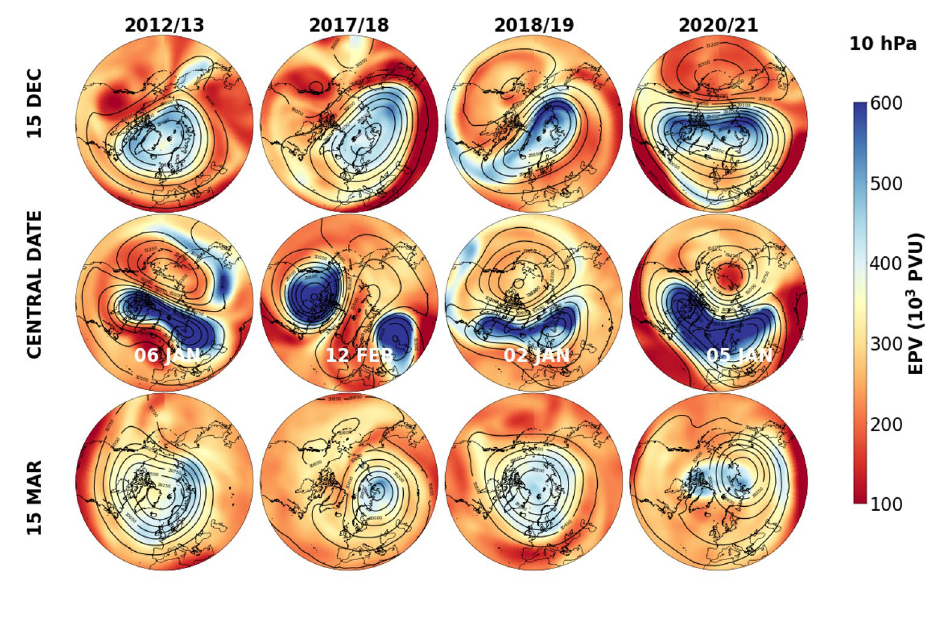
Fig. 4 Evolution of the PV maps for the similar period as depicted in this figure, but for the 70 hPa/17 km/475 K